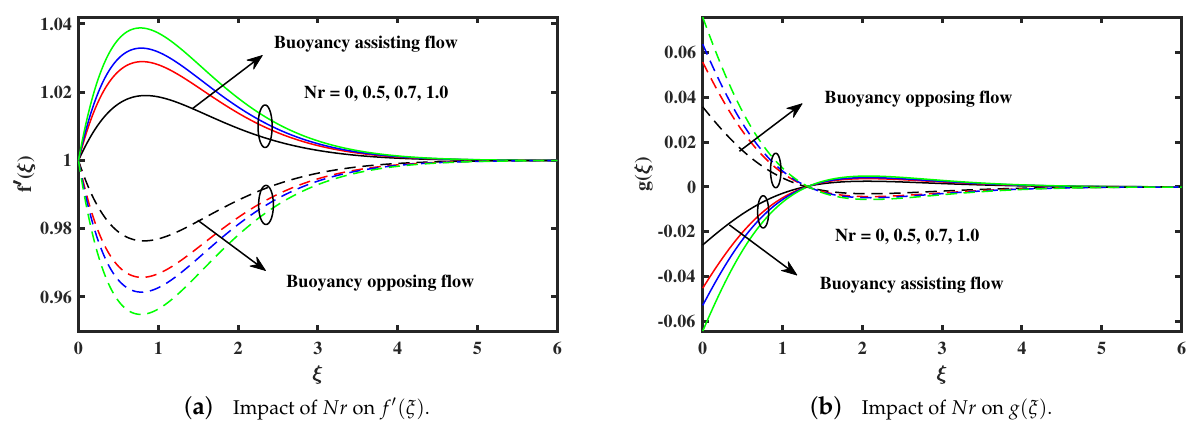
Figure 5. Fluctuation of f (cid:48) ( ξ ) and g ( ξ ) against buoyancy ratio ( Nr ).